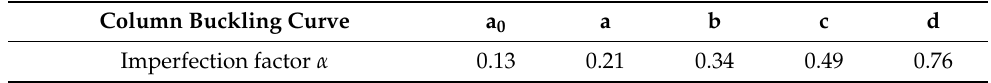
Table 6. Imperfection factors for buckling curves in EN 1993-1-1 [17].